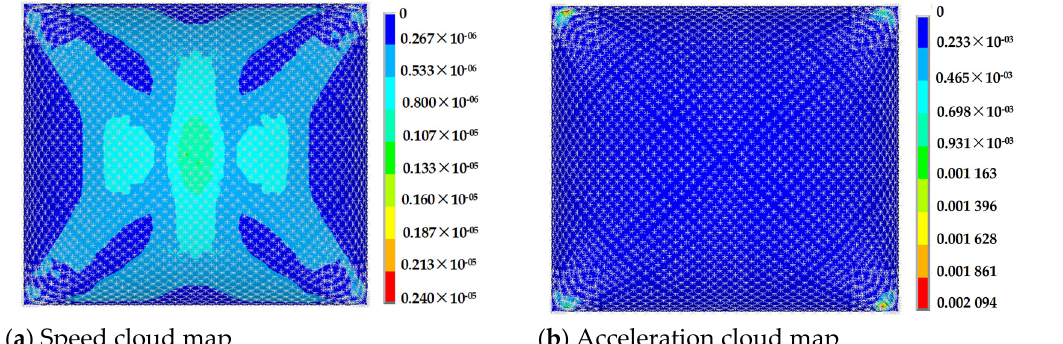
Figure 8. Sliding Contact Analysis Results.